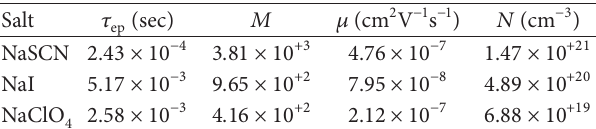
Table 2: Values of 𝜏 and NaSCN) containing systems.